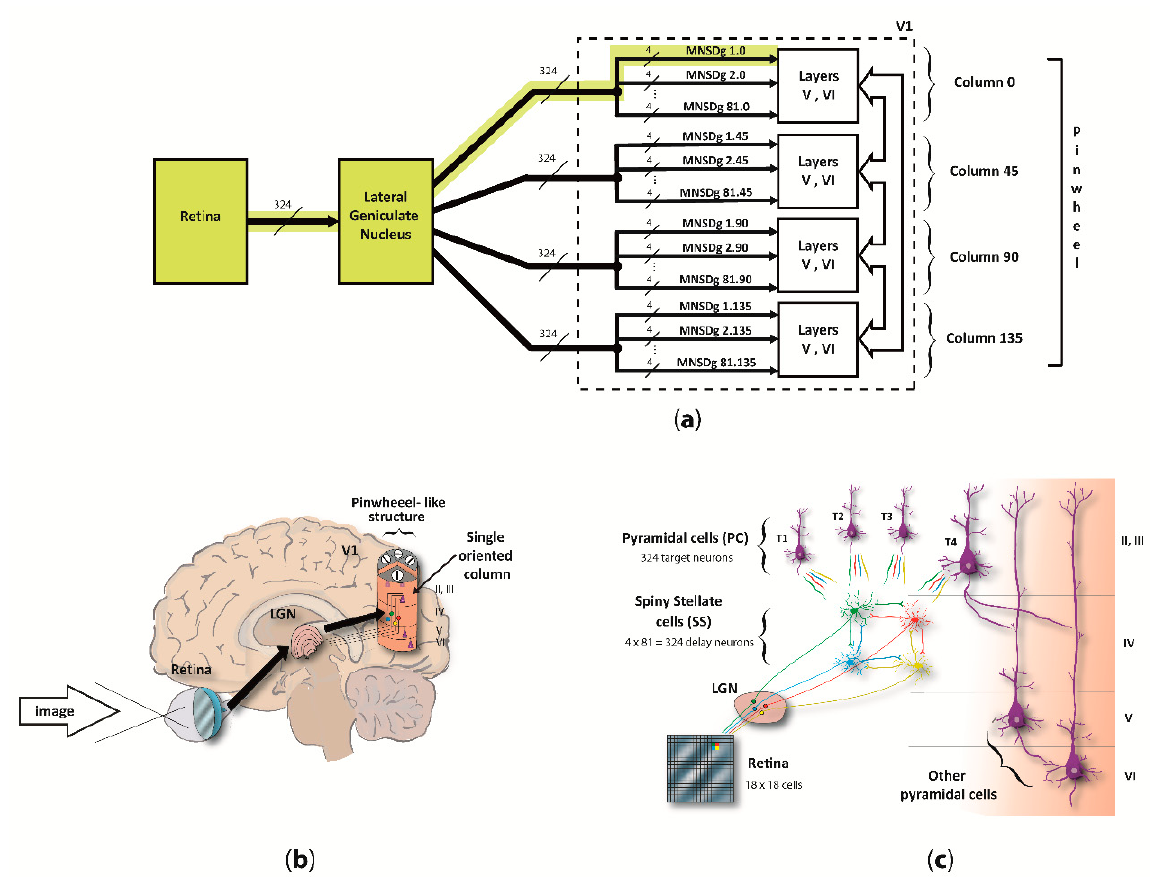
Figure 1. Illustration of the RVSM.: ( a ) Wiring scheme of the complete system, from the 324 cells of the retina to the MNSD-based microcircuits residing in layers II/III and IV (connection cardinality is indicated along the tracts). Each one of the 4 columns (i.e., column 0 , column 45 , column 90 and column 135 ) is composed of 81 MNSD groups, and indicated with the notation ID MNSD group .ID column (e.g., MNSDg 2.45 means the 2nd MNSD group of cortical column 45). Neurons of layers V and VI are shared among the MNSD structures; ( b ) Anatomical contextualization of the neuronal path highlighted in ( a ): from stimulus presentation to one of the four V1 oriented columns composing the pinwheel-like structure; ( c ) Diagram of neuronal connections from a specific section of the retina (represented by 4 neighboring cells out of the 324) to a single MNSD-based microcircuit of one of the four cortical columns (delay neurons of layer IV to target neurons of layer II/III). The output connections to layers V and VI are shown for one of the targets only. For ease of understanding, in ( b ) we depicted only the MNSD structure formed with one of the targets, although each set of four delay neurons (layer IV) is connected to four target neurons (levels II/III) giving rise to four different MNSD structures, i.e., a MNSD group (as specified in ( c )). The reader can find a precise description of the network in the Section Materials and Methods and in Appendix B.